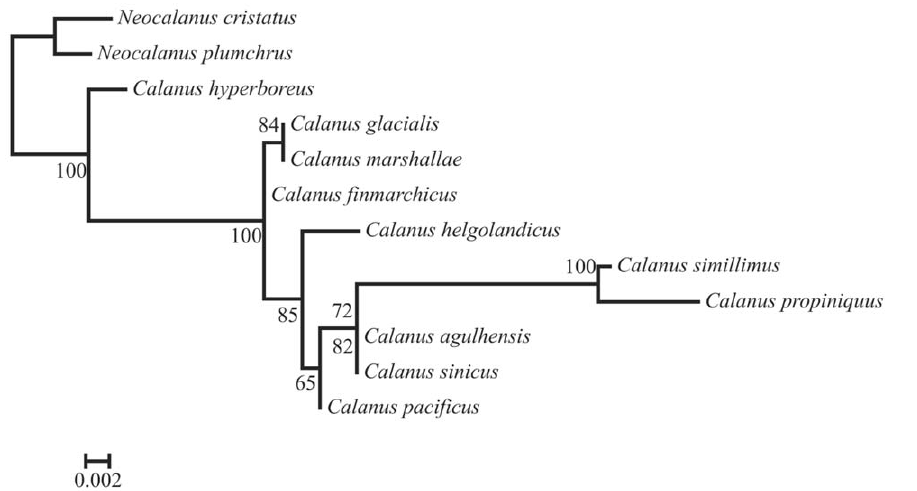
Figure 3. Maximum Likelihood tree for 10 species of Calanus . Tree is based on a 658 bp region of the 28S rRNA gene under GTR. Numbers at nodes indicate percentage of recovery after 1,000 bootstraps.